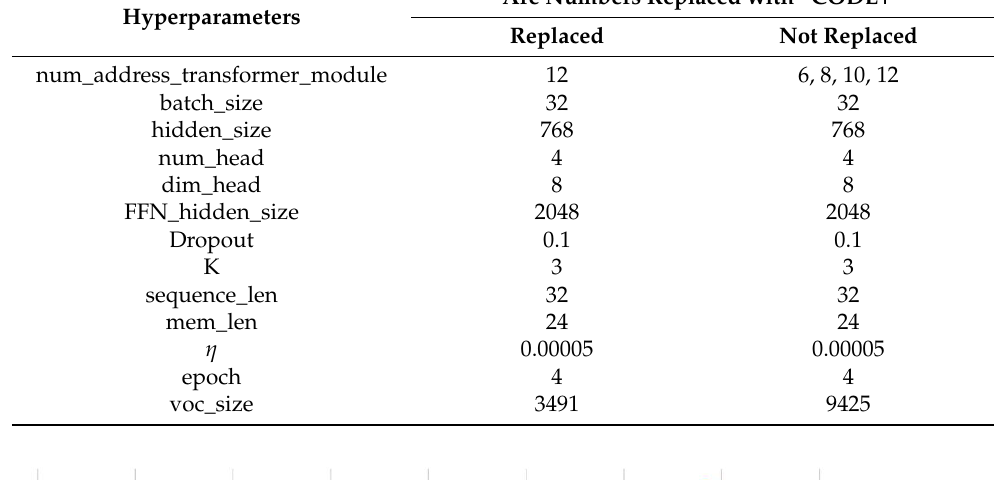
Table 3. Setting values for each hyperparameter of the ASM.